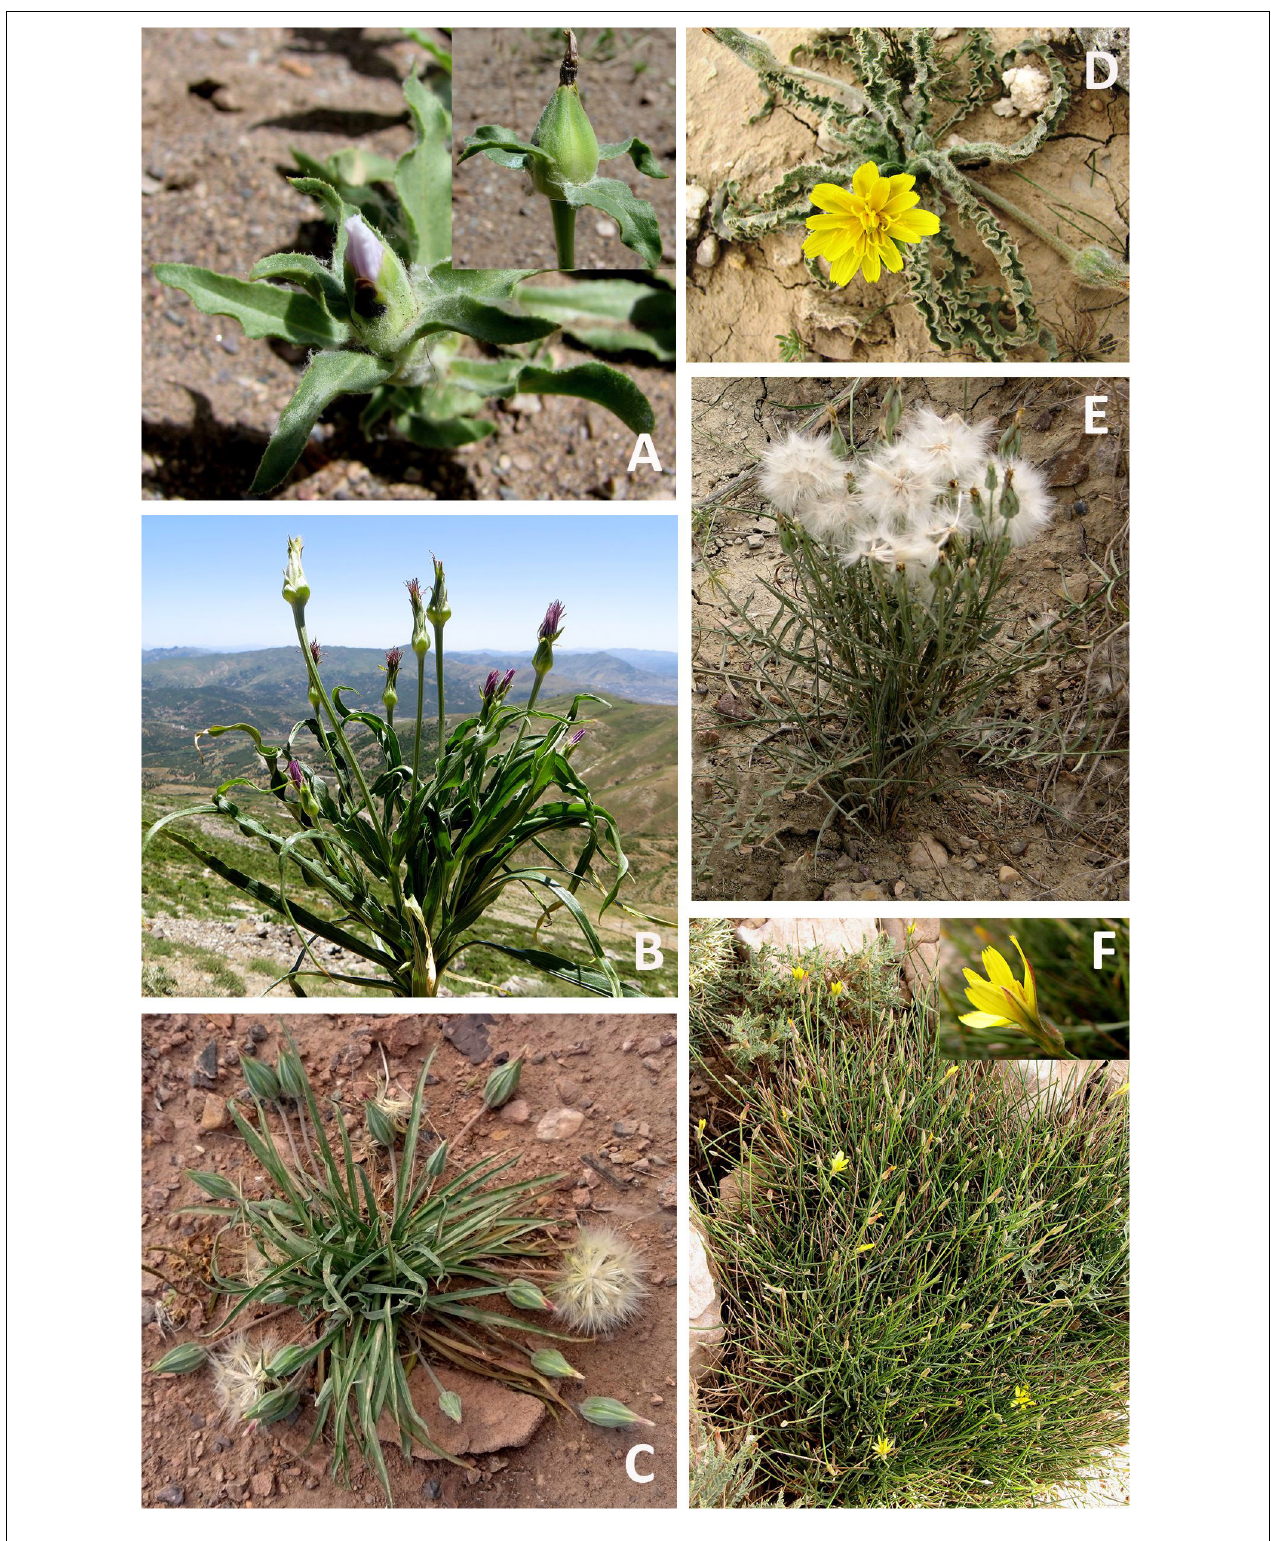
FIGURE 1 | Diversity in Scorzonerinae shown by photographs of representative species. For each image, locality, and date of the photograph are given. (A) Epilasia acrolasia , Iran, Kerman, Rafsanjan, Khenaman village, 19 April 2007; (B) Pseudopodospermum phaeopappum , Iran, Kordestan, Baneh, May 2019; (C) Pterachaenia stewartii , Iran, Kerman, near Dehbala village, 15 May 2019; (D) Gelasia lanata , Iran, Khuzistan, 11 km from Bagh-Malek to Meidavud, 9 March 2007; (E) Scorzonera persepolitana , Iran, Esfahan, near Delijan, on clay hill, 20 May 2019; and (F) Scorzonera rupicola , Iran, Bakhtiari, between Esfahan and Shahrekord, 2 July 2010. All photographs by M.